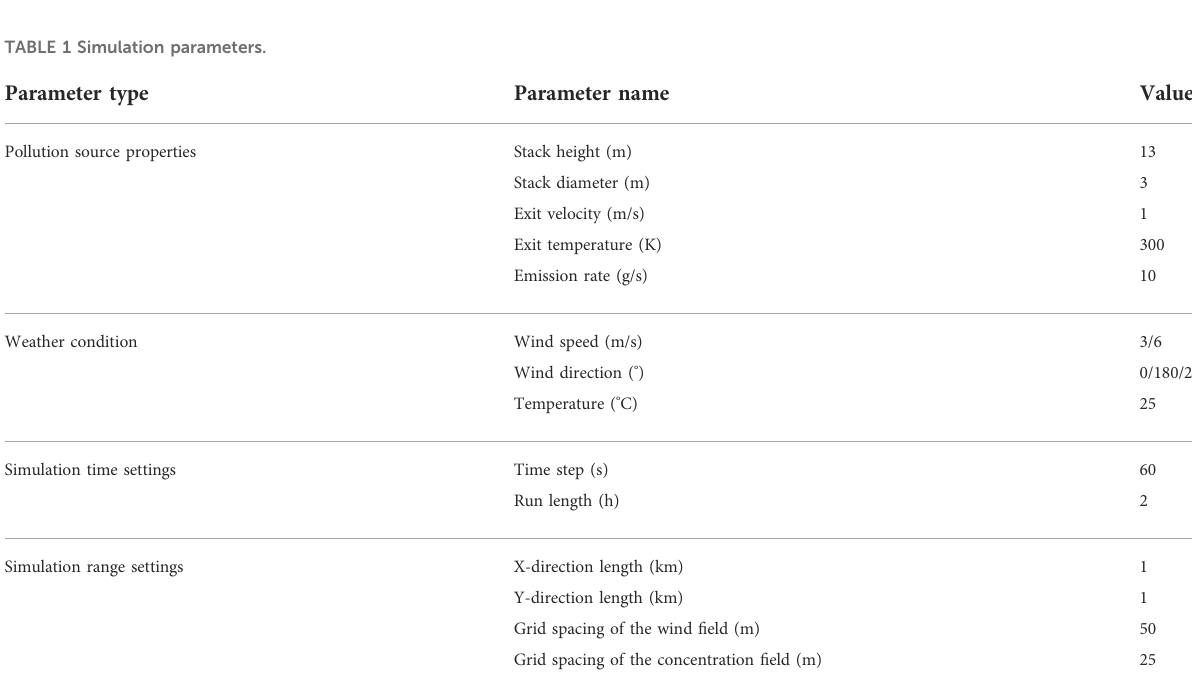
TABLE 1 Simulation